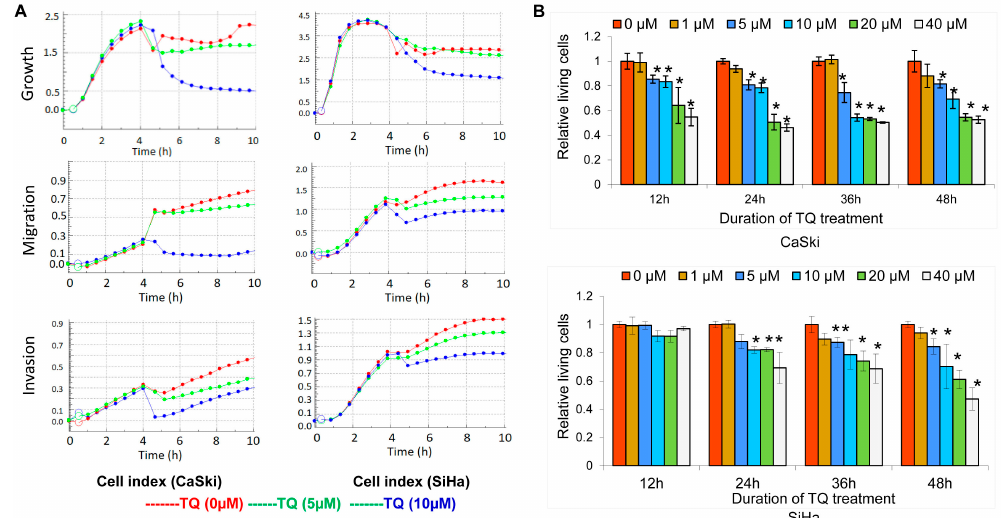
Figure 1. Effects of TQ on cell growth, migration and invasion in CaSki and SiHa cell lines. ( A ) Cell viability assay (CCK8 assay) also showed that treatment of TQ at a dose of 5 µM or more for 24 h or more shows significant cytotoxic effects on both CaSki and SiHa cell lines (* p < 0.05) ( B ). B SiHa TQ (µM): TQ (µM): 0 0